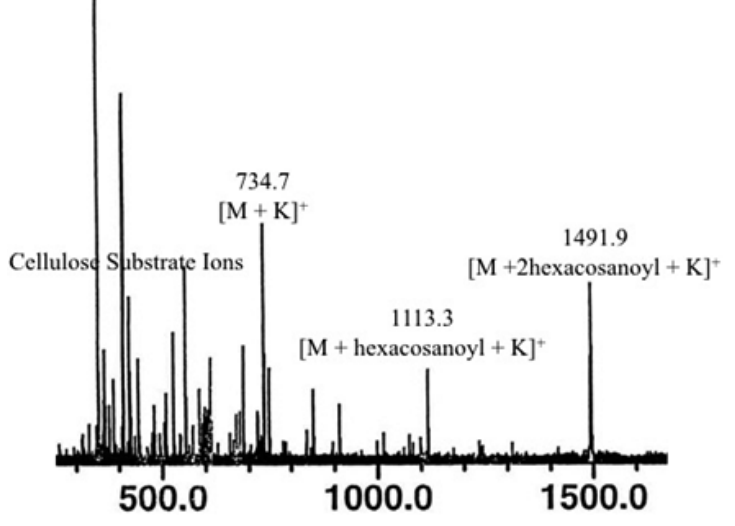
Figure 3. Direct laser desorption ionization (DLDI) mass spectrum of the hexacosanoylchloride coupling reaction B. [M + K] + , desired one covalent addition is observed for the product along with second and third covalent additions of hexacosanoyl to phytosphingosine.